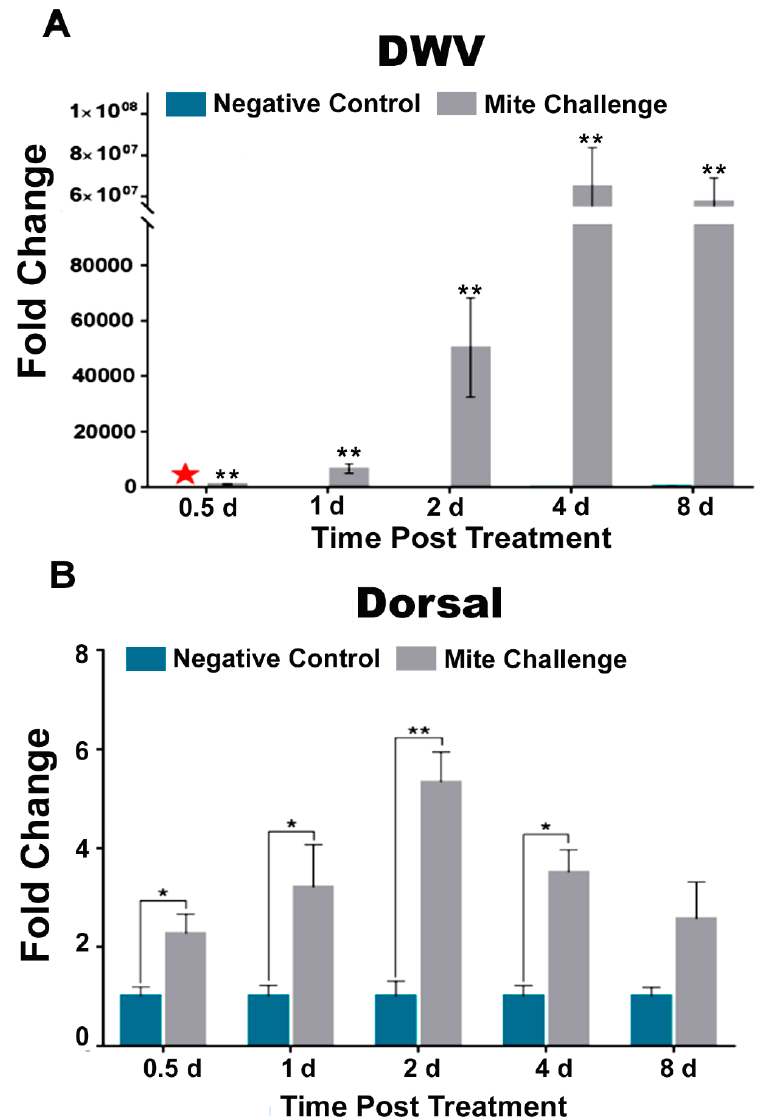
Figure 1. The concentration of DWV and the expression levels of the transcription factor Dorsal. ( A ) Fold changes of DWV between the negative control (without Varroa challenge) and the groups challenged with Varroa mites at the different time points post treatment. Bees infested with Varroa mites show significantly higher levels of the DWV compared to bees without exposed to Varroa challenge (star denotes calibrator; ** p < 0.01). ( B ) Fold changes between the negative control (cyan) and challenged bees (grey) at the different time points post treatment (* p < 0.05, ** p < 0.01).